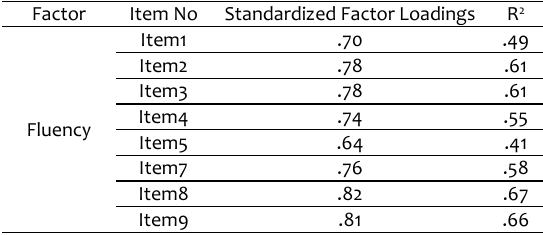
Table 3: Standardized Factor Loadings and Explained Variance (R 2 )